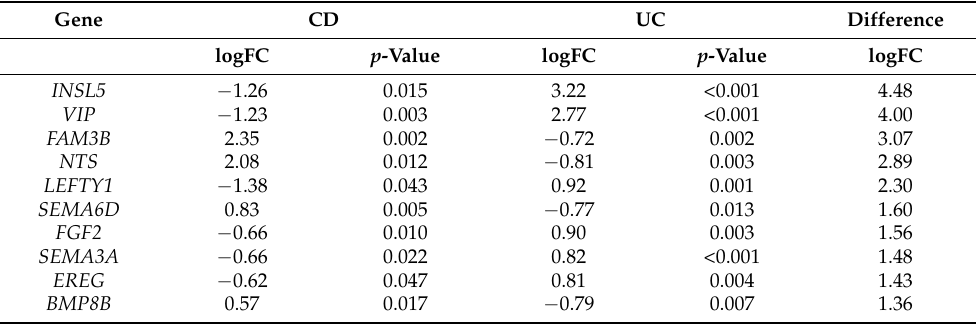
Table 4. Differentially expressed genes with inverse regulation in ulcerative colitis and Crohn’s disease. CD, Crohn’s disease; UC, ulcerative colitis; logFC, logarithm of fold change.